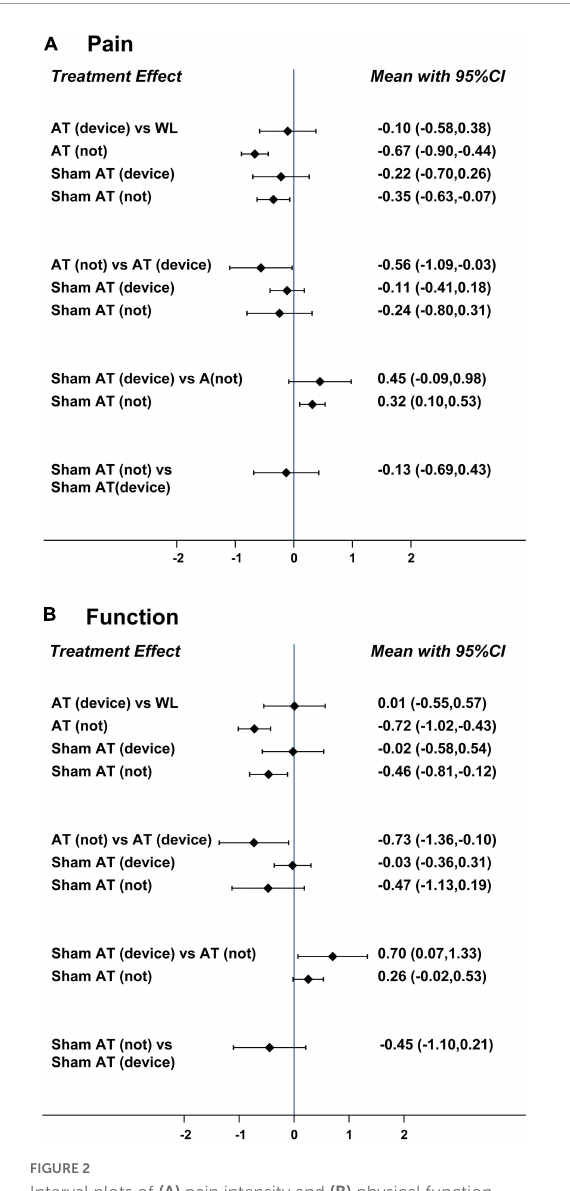
FIGURE2 Interval plots of (A) pain intensity and (B) physical function. AT (device), verum acupuncture in sham